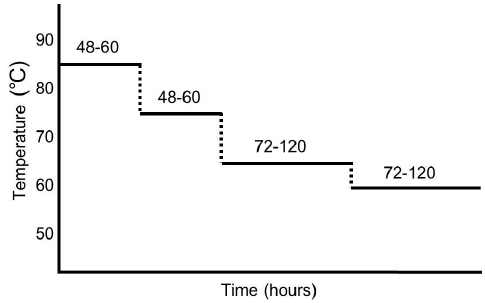
Figure 1. An example representing aging processes for aged black garlic (ABG) production. This protocol